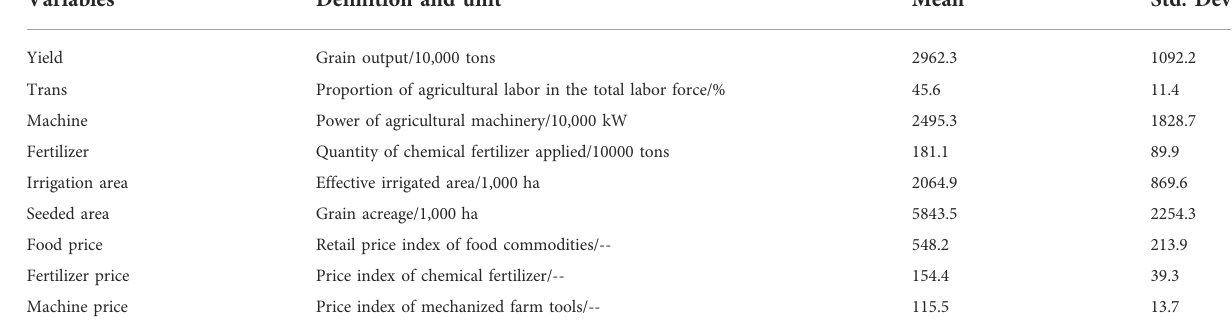
TABLE 2 Descriptive statistics of the main variables.